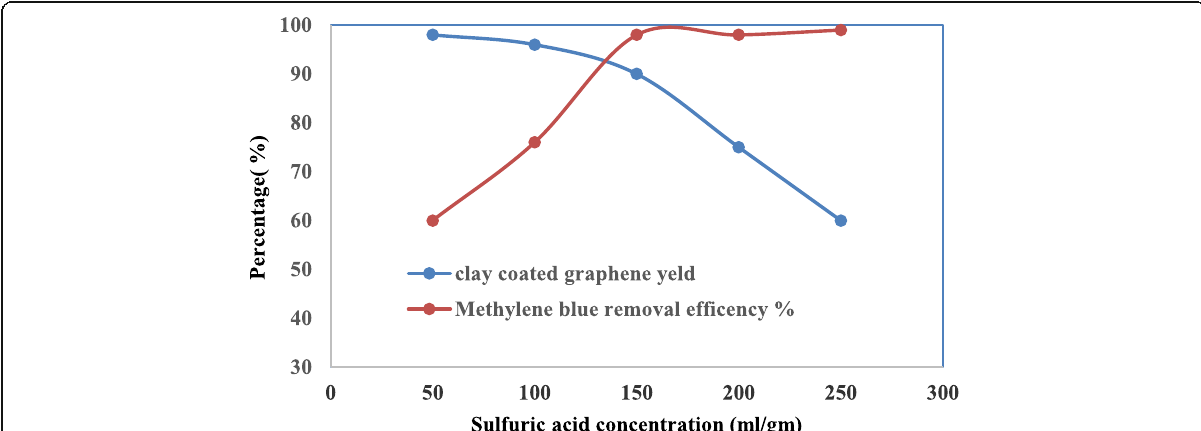
Fig. 5 Effect of sulfuric acid concentration on the clay coated graphene oxide yield and methylene blue removal efficiency, (bentonite substrate